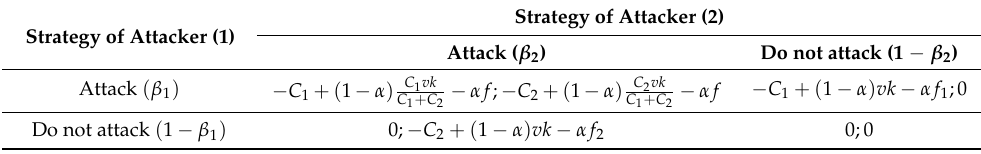
Table 2. Payoff matrix of the two non-cooperative attackers.